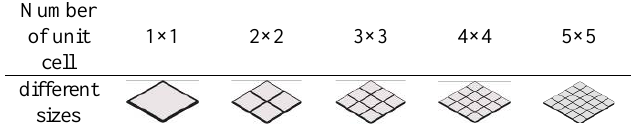
ird order vibration response with the dif- Table 16. The th ferent size square and rhombic cores N